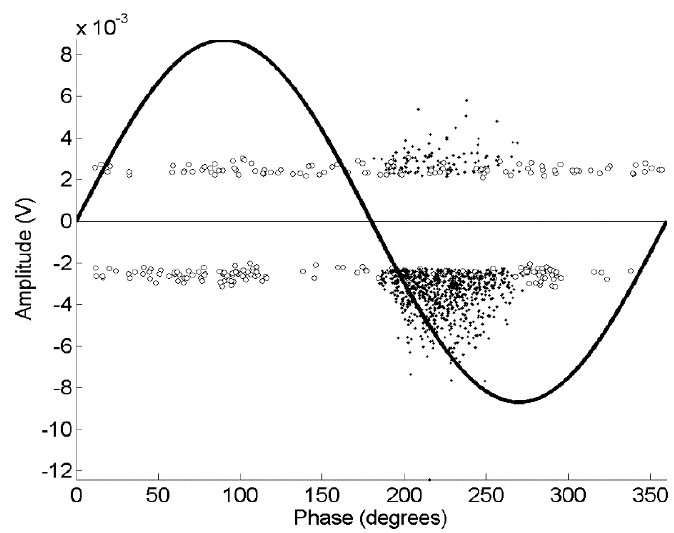
Figure 9. PRPD plot of the events in the cable classified as noise with white circles and not-noise (or partial discharges) with black points. Table 5. Agreement in percentages between OCSVMs trained using default mode signals recorded at the cable experiment (rows) and OCSVMs trained using background noise recorded at other experiments (columns). The top row shows results without domain adaptation, while the bottom row incorporates a domain adaptation consisting in tuning the value of (cid:2025) in the OCSVMs learned with noises of other experiments with the noise pulses recorded at the Cable. The test set includes both PD and noise recorded at the cable.